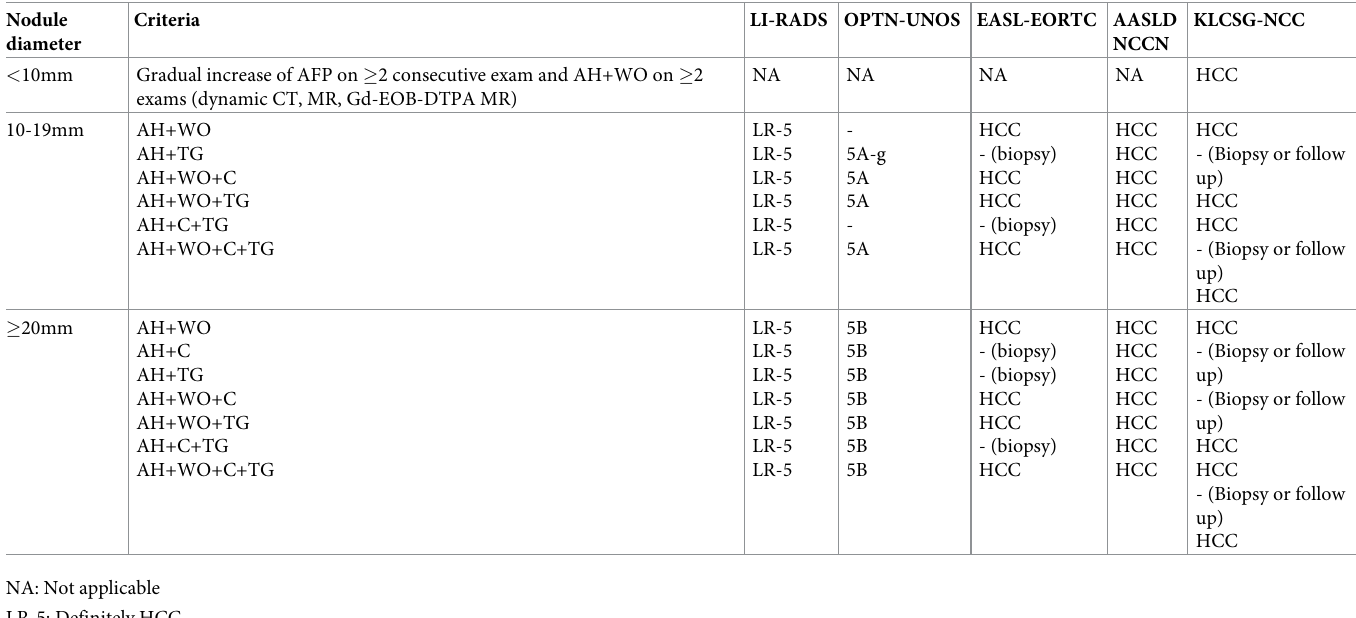
Table 2. Diagnostic criteria of the